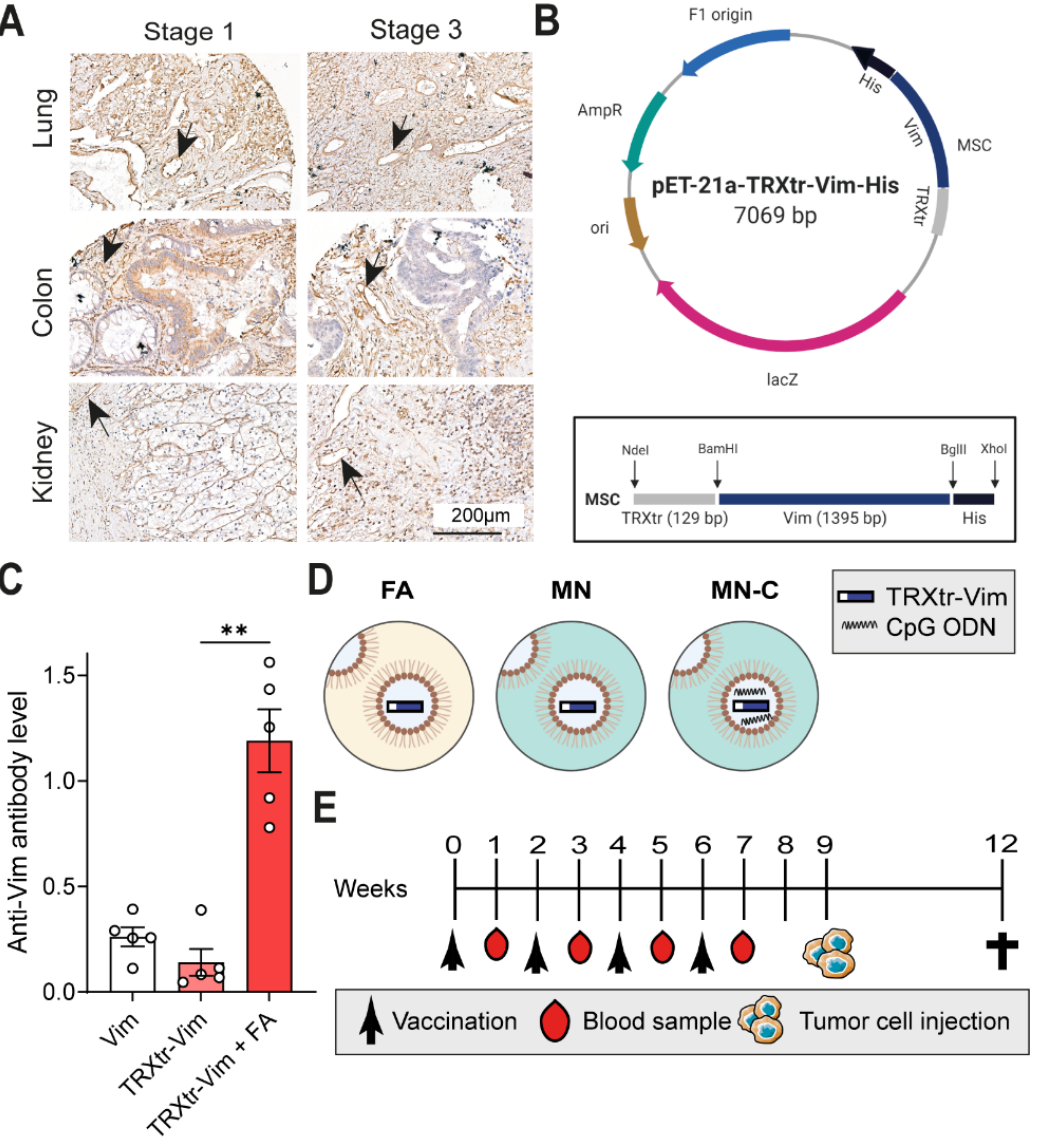
Figure 1. Vimentin expression in cancer tissues and study setup. ( A ) Representative images of vimentin expression in human tumor tissues from in-house developed TMA, at a 100x magnification. Arrows indicate a vimentin-positive blood vessel present in the tissue. ( B ) The pET21a expression vector for production of TRXtr-Vim. The DNA sequences of the different protein constructs (insert) were inserted between the restriction sites Nde1, BamH1, and Xho1 in the multiple cloning site, as indicated in the black rectangular. ( C ) Anti-vimentin total immunoglobulin (Ig) levels in serum after the third vaccination measured at a 1:100 serum dilution by ELISA at OD655 nm. Vaccination was performed with either only vimentin protein (Vim), TRXtr-Vim protein (TRXtr-Vim), or TRXtr-Vim combined with Freund’s adjuvant (TRXtr-Vim + FA). ( D ) Schematic overview of the treatment groups. FA is Freund’s adjuvant, MN is Montanide ISA 720 adjuvant, and MN-C is Montanide ISA 720 supplemented with CpG, a TLR9 agonist. ( E ) Schematic overview of the vaccination and tumor growth schedule. Mice were vaccinated four times at two-week intervals. One week after each vac- cination, a blood sample was taken. In week 9, B16F10 melanoma cells were injected subcutaneously and tumor growth was monitored. Figure created with BioRender.com. ** p < 0.01.